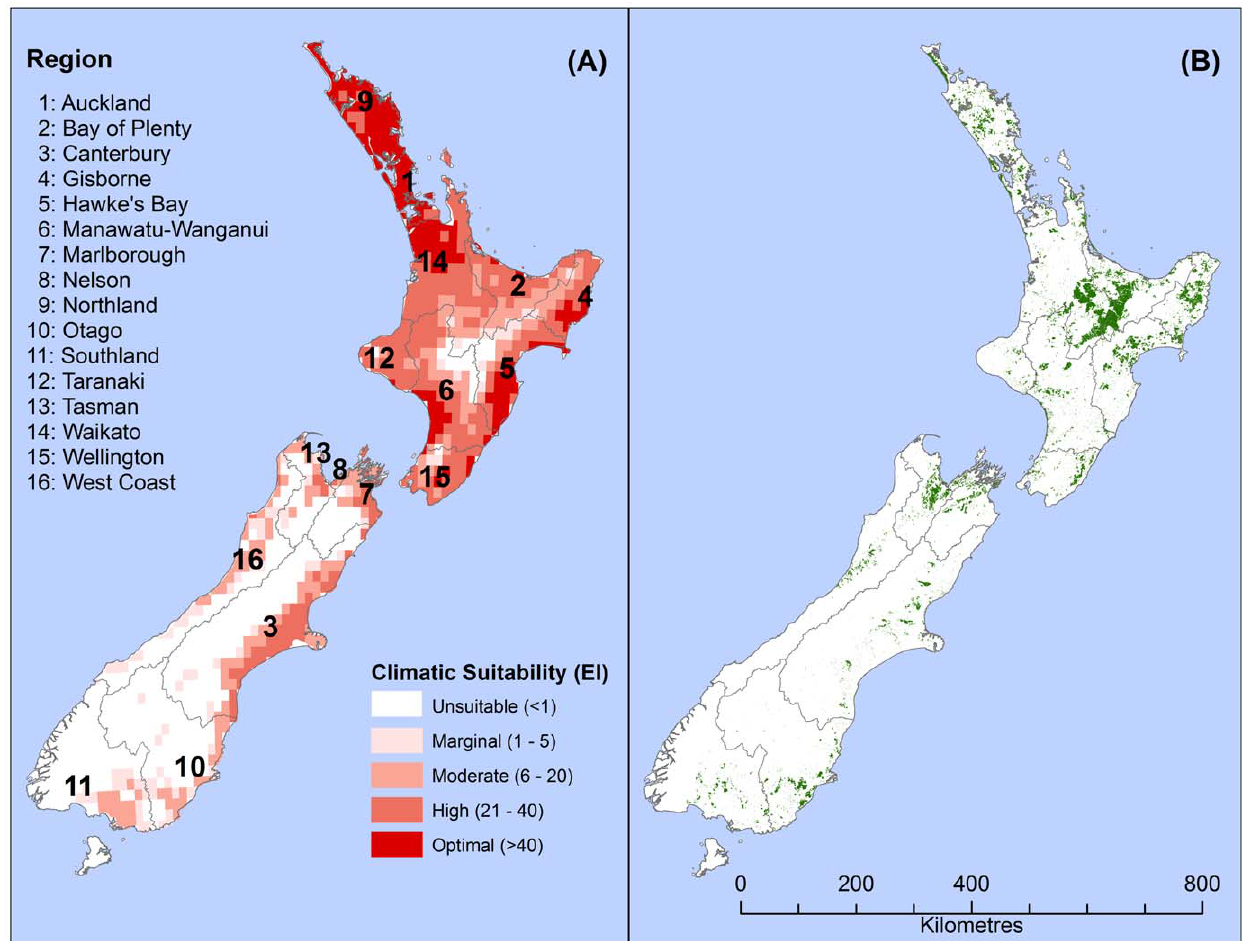
Figure 6. New Zealand map showing: (a) climatic suitability, by region, under current climate for Thaumetopoeapityocampa using CLIMEX Ecoclimatic Index (EI), and (b) existing (green) pine plantations [ 69 ] . Projection: New Zealand map grid.